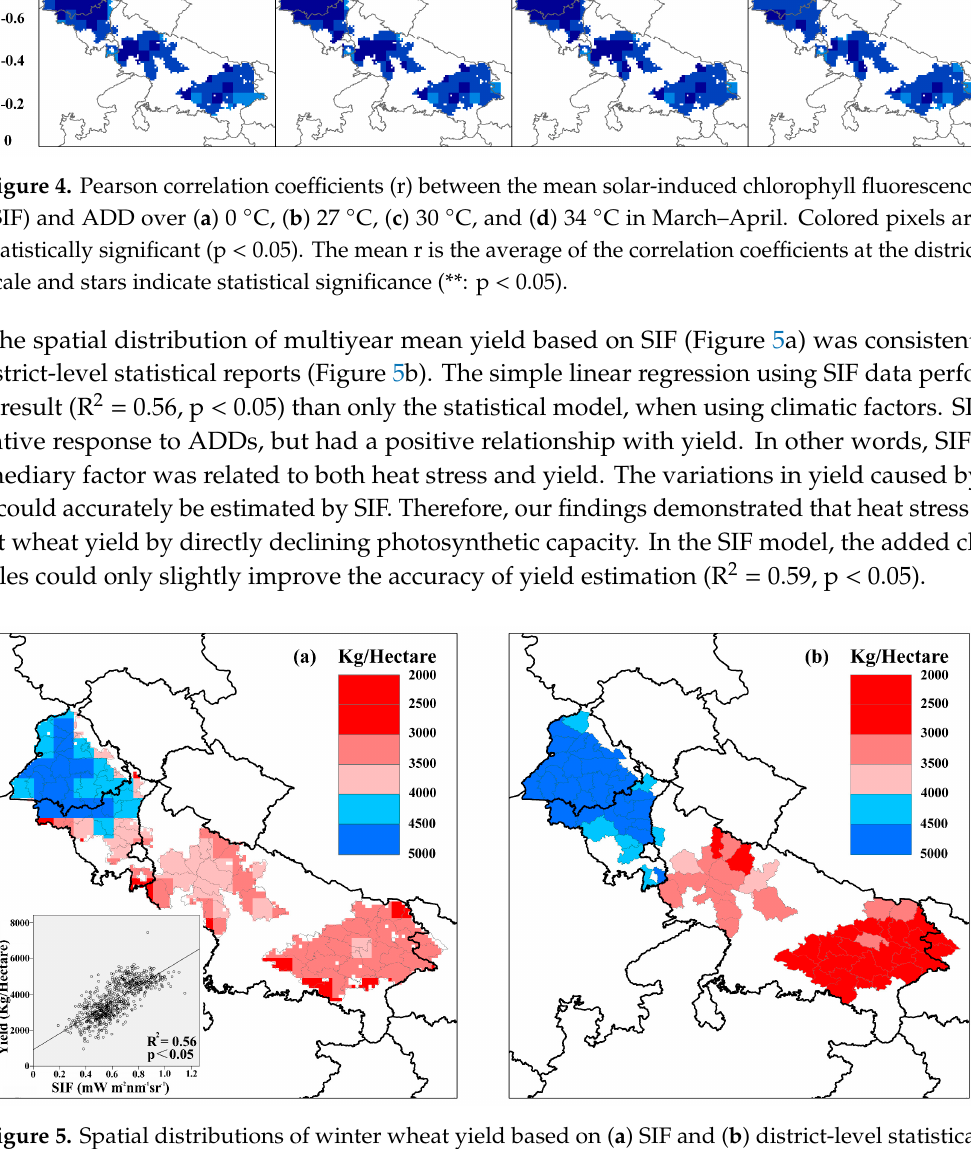
Figure 5. Spatial distributions of winter wheat yield based on ( a ) SIF and ( b ) district-level statistical reports. The scatter plots in the bottom-left corner show the relationship between the yield and SIF at the district scale, each dot represents the mean SIF in March–April and statistical yield, for each district and one year.